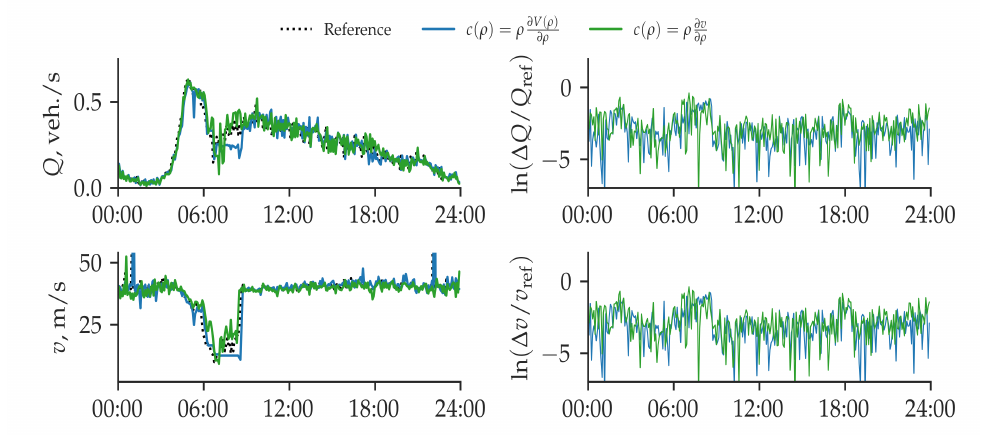
Figure 5. The comparison of calculated flows (top) and velocities (bottom) from the first lane of I-580 and observed values from detector #2 (dashed grey lines). On the right, flow (top) and velocity (bottom) relative errors in logarithmic scale. The simulation results obtained with a different expression for the relative velocity of the congestion propagation, c ( ρ ) , are shown in different colors: ( ρ ) green, model (with c ( ρ ) = ρ ∂ v from (29); blue, the same model (15) with c ( ρ ) = ρ ∂ V ∂ρ empirical function of density.